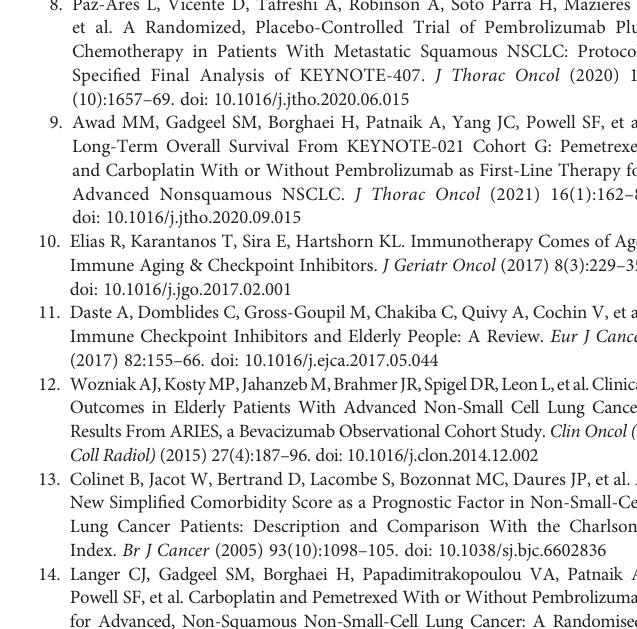
Supplementary Table 1 | Treatments after disease progression in different treatment